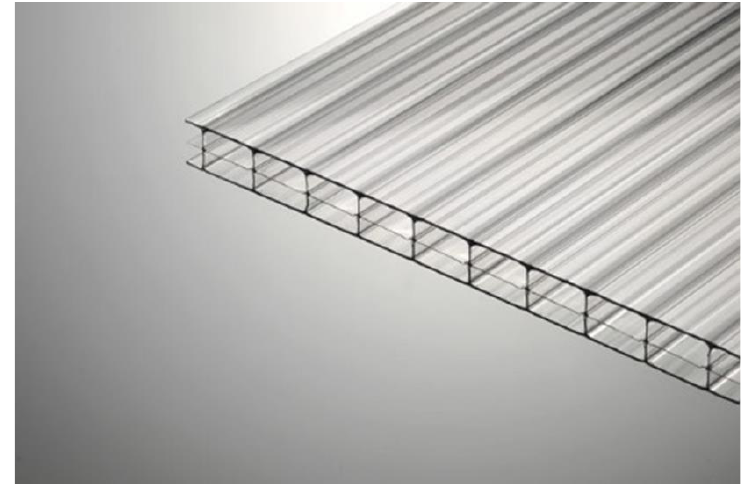
Figure 1. A 16 mm Multiwall PC Plate.